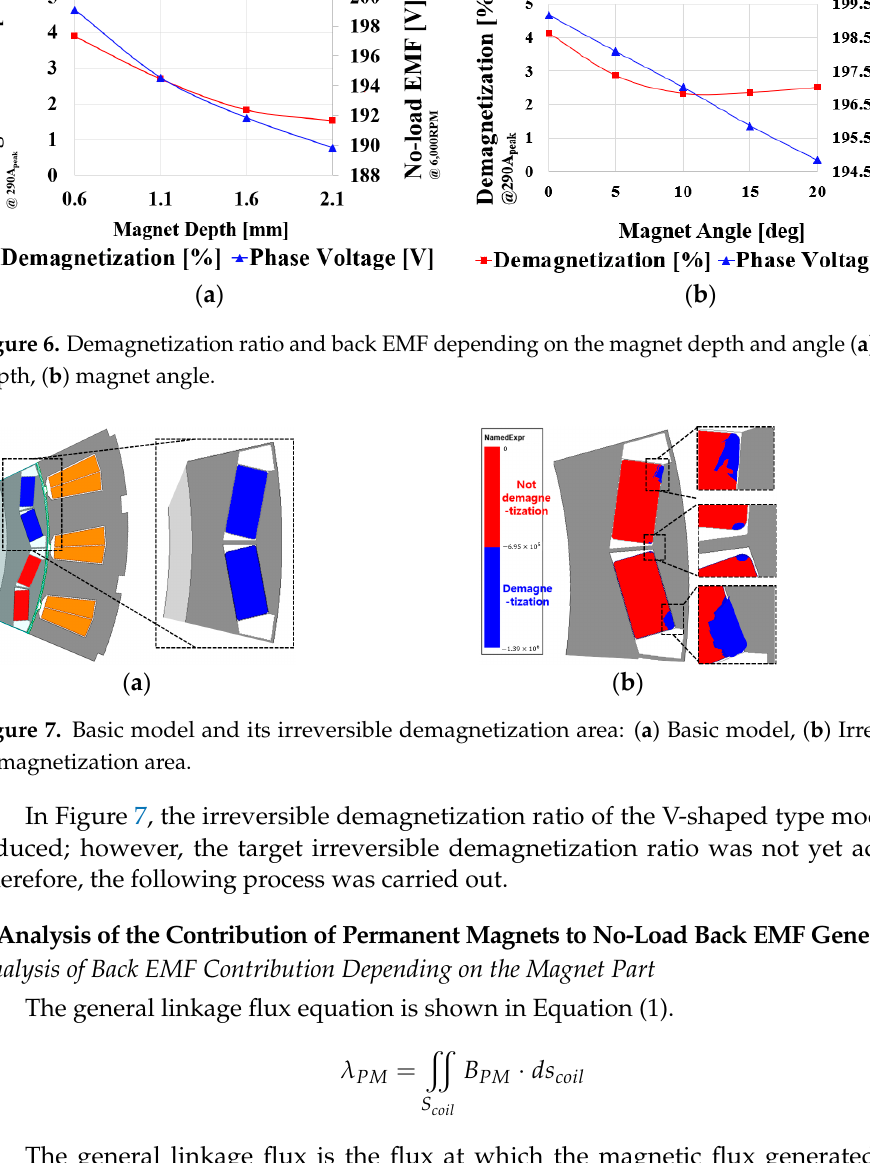
Figure 6. Demagnetization ratio and back EMF depending on the magnet depth and angle ( a ) magnet depth, ( b ) magnet angle.